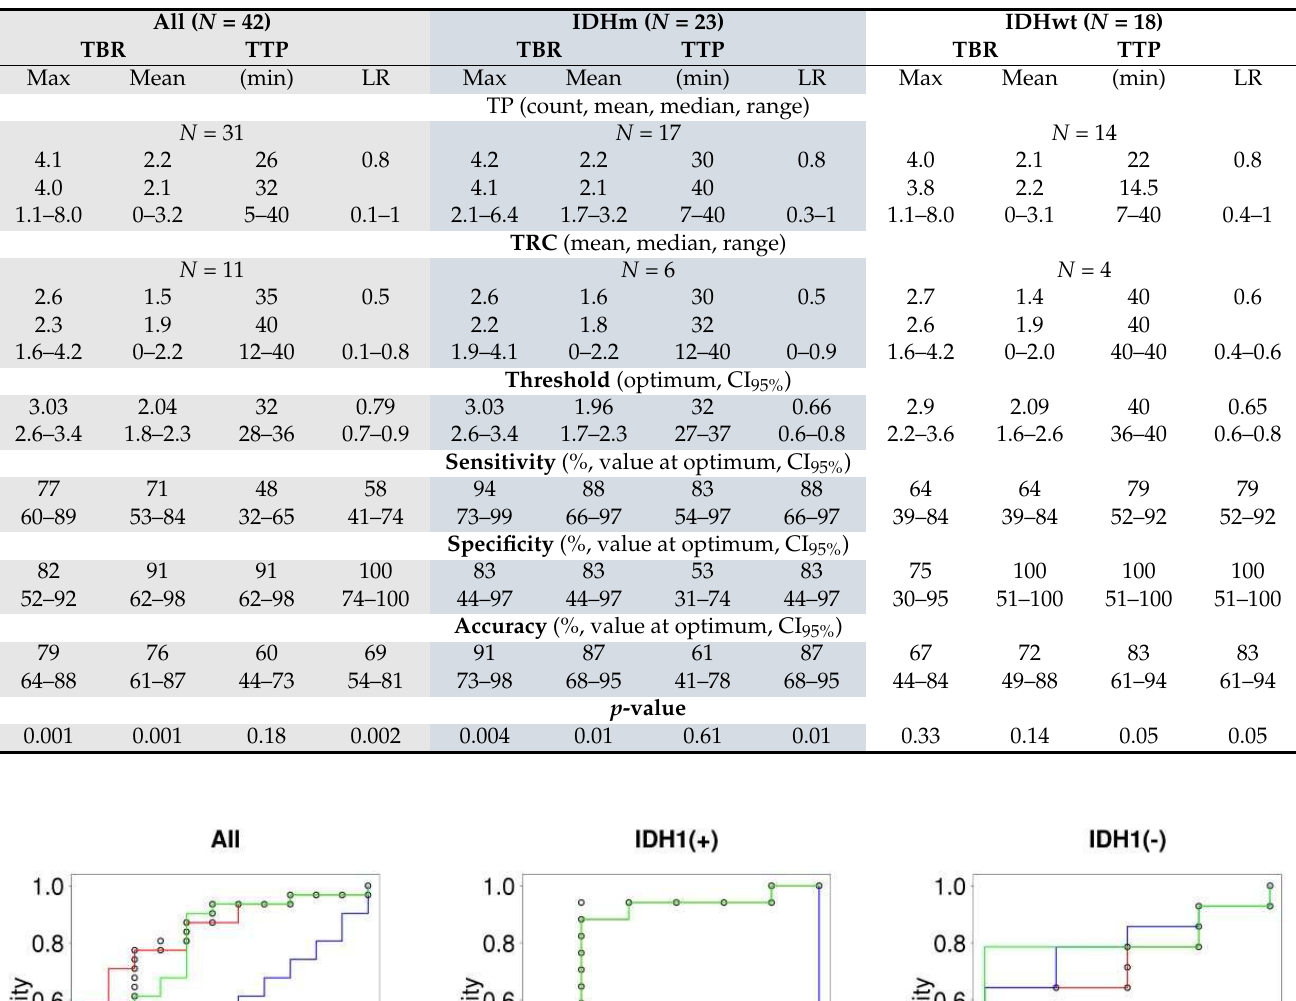
Table 1. Analysis of sensitivities, specificities, thresholds and diagnostic accuracy of 18 F-FET PET biomarkers in differentiation between late TP and TRC in glioma patients.